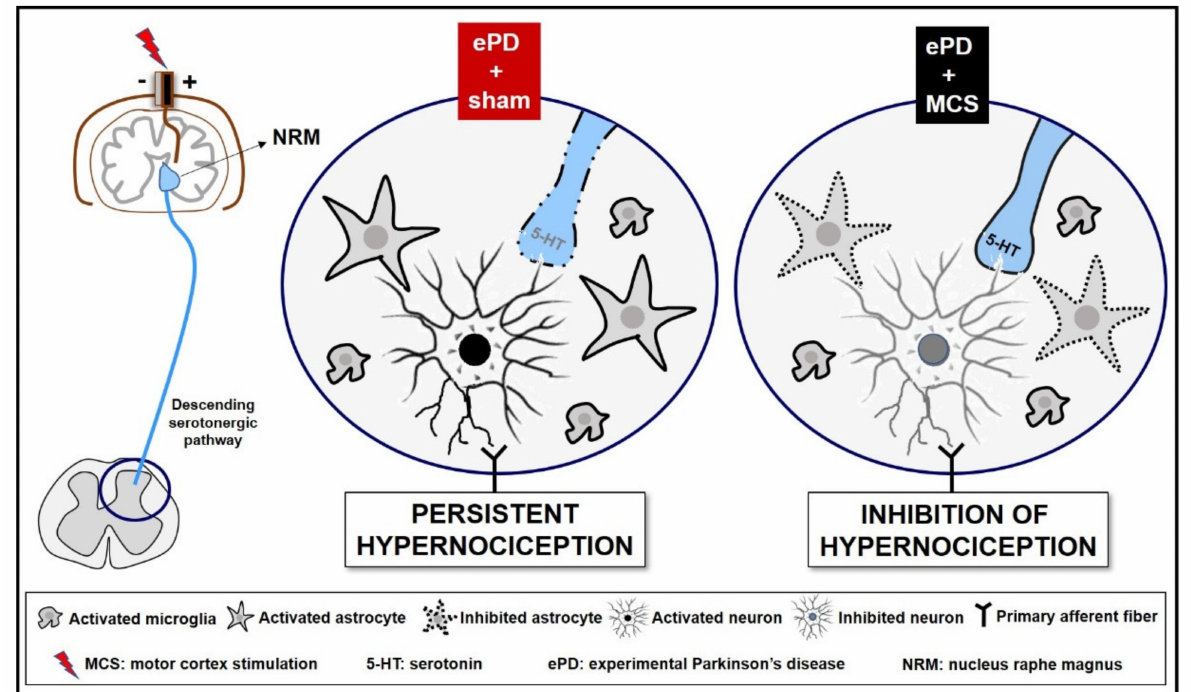
Figure 5. Representative scheme descending analgesic control in an experimental Parkinson’s disease (ePD) model comparing animals treated with motor cortex stimulation (MCS) or sham. The striatal 6-OHDA, beyond the progressive dopaminergic loss in the nigrostriatal pathway, decreased the serotonin immunoreactivity in the nucleus raphe magnus (NRM). This serotonergic nucleus projects to the dorsal horn of the spinal cord (DHSC) to control the ascendant nociceptive inputs. However, probably due to loss of serotonergic efferences in the spinal cord, the ePD induced an increase in neuronal activation, and increased immunoreactivity of astrocytes and microglial hyperplasia and hypertrophy in the DHSC, a phenomenon responsible for the maintenance of hypernociception pain. The MCS was able, not only to restore, but also increase the serotonin immunoreactivity in the NRM, without change in dopamine loss induced by ePD. In addition, the MCS decreased the neuronal activation pattern and the immunoreactivity of astrocytes in the DHSC, without interfering with the ePD-induced microglial hyperplasia and hypertrophy. Taken together, we suggest that MCS-induced analgesia is partially due to restoration of the descending serotonergic pathway resulting in the increase in spinal serotonin release, with consequent inhibition of the hyperactivation of spinal neurons and astrocytes in hemiparkinsonian rats. Different monoamines, such as dopamine and noradrenaline, play an important role in pain control and may be also related to the MCS-induced analgesia in ePD